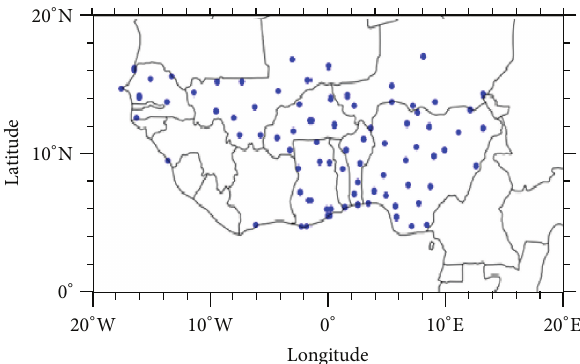
Figure 3: Spatial distribution of the Eighty-One (81) ground observation precipitation data sites